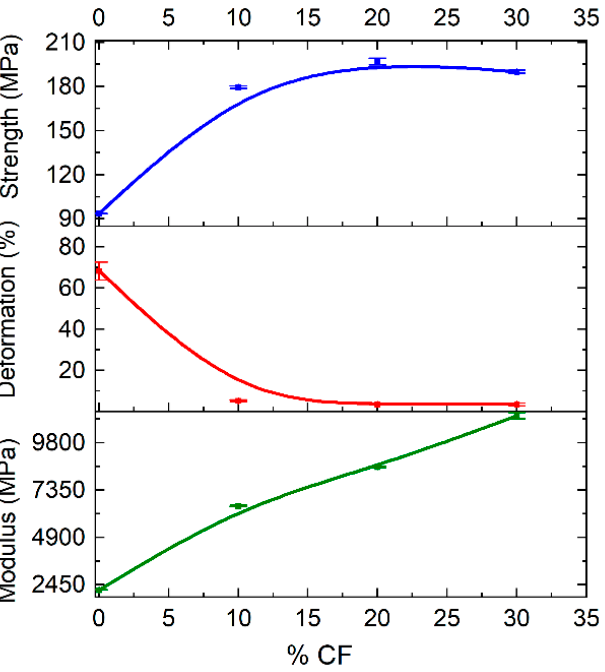
Figure 6. Dependence of strength, modulus of elasticity, and deformation at break of the R-BAPB- based molded samples on the concentration of CF.